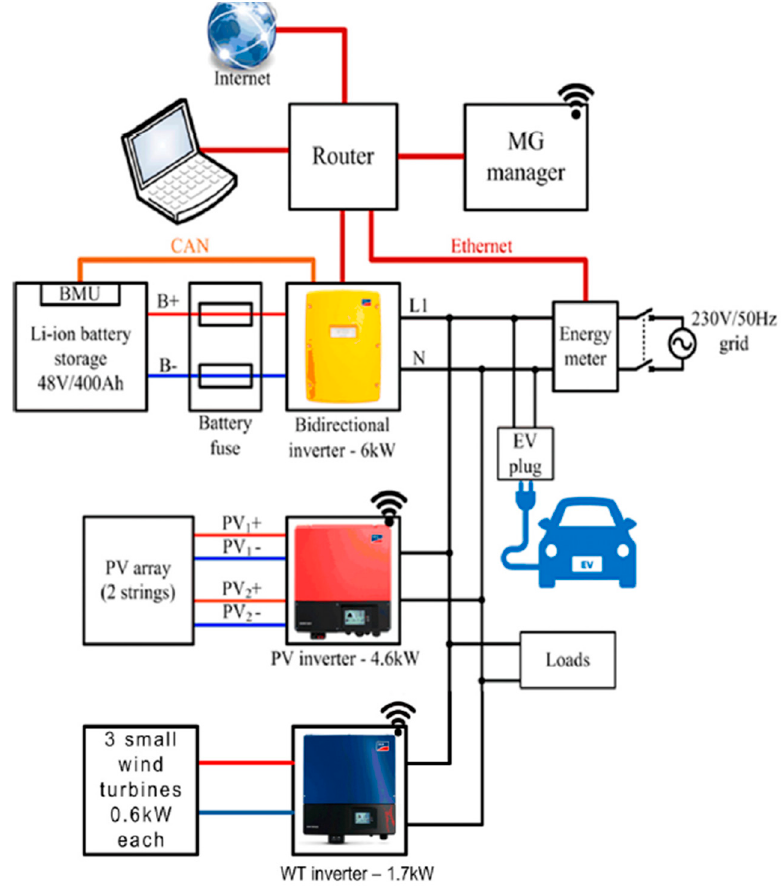
Figure 4. The structure of a residential smart MG supplied by renewable sources with EV charging station capabilities and public access [10] .